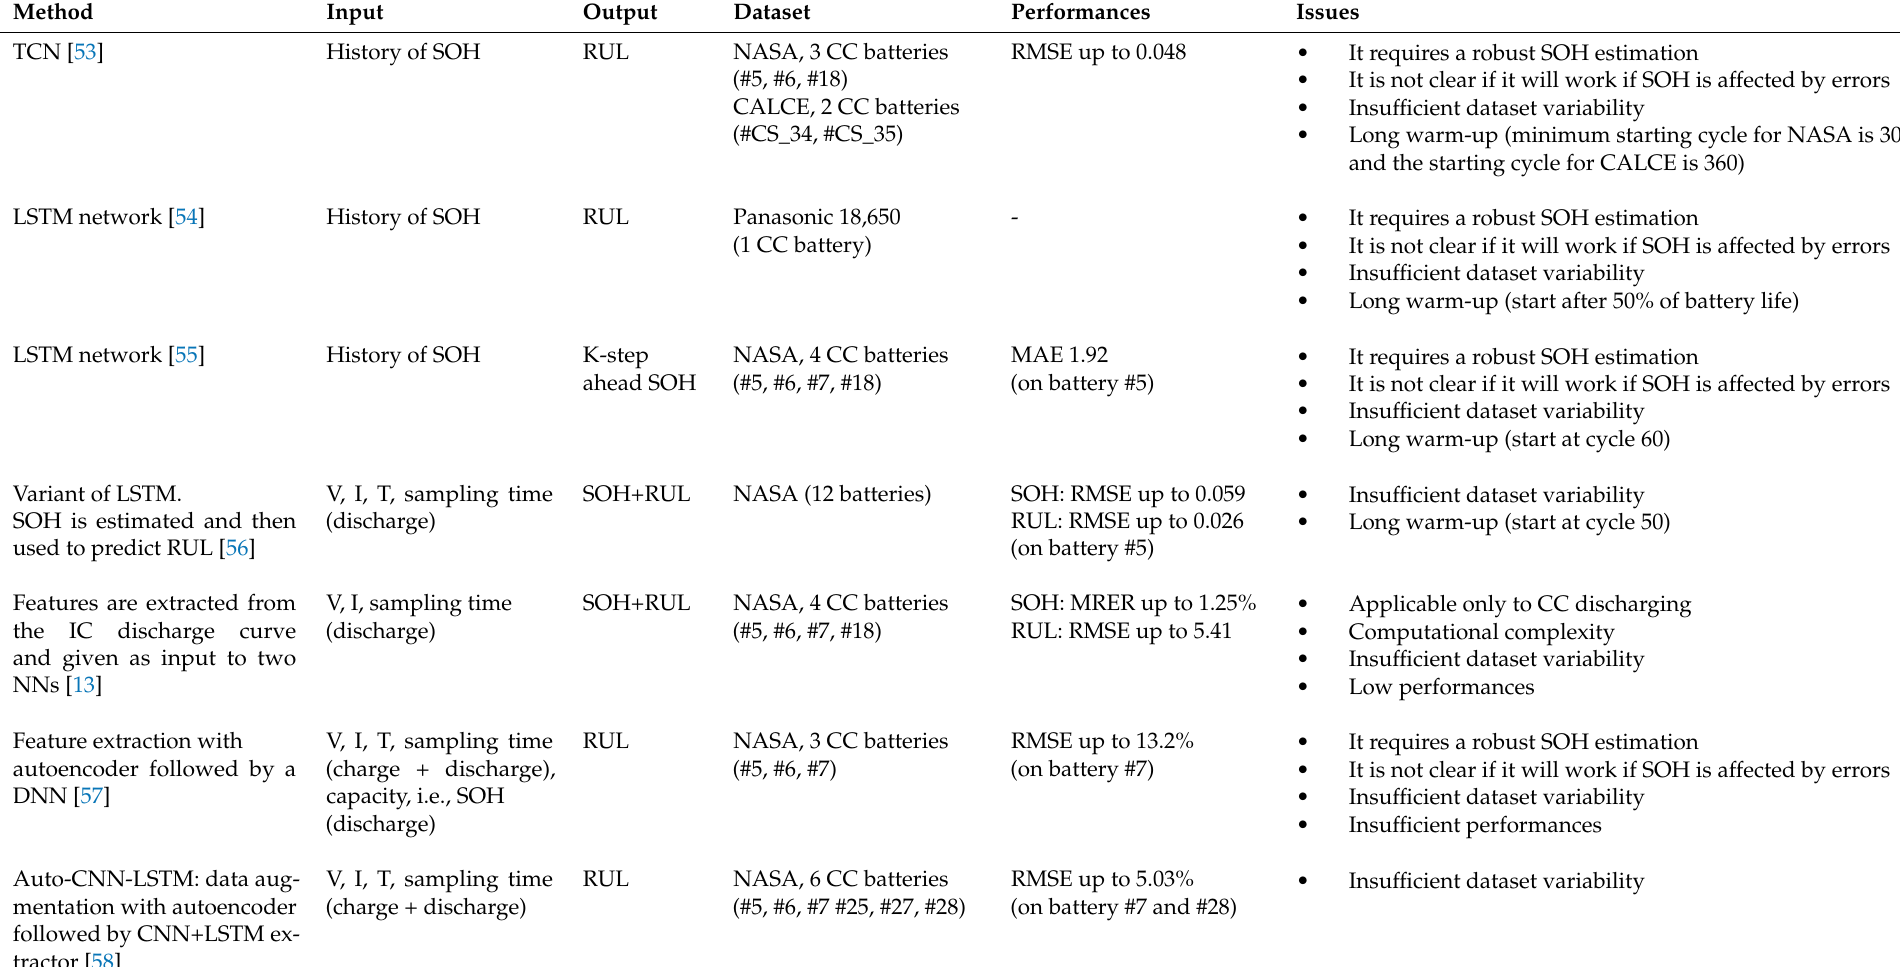
Table 1. Summary of current DL-based RUL estimation